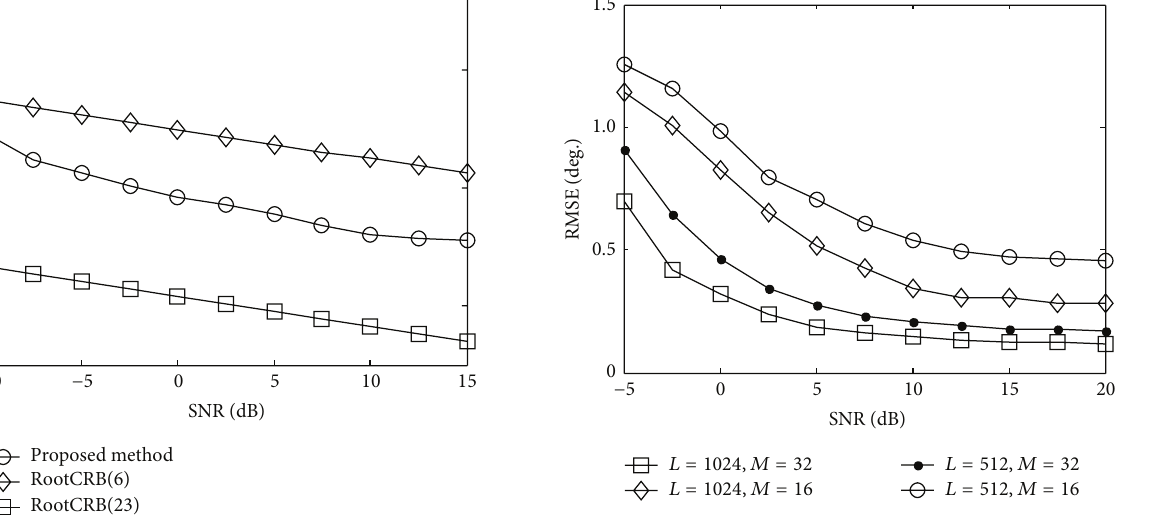
Figure 5: RMSE of spatial frequency versus SNR, 𝑁 = 6 and 𝐾 = 5 .